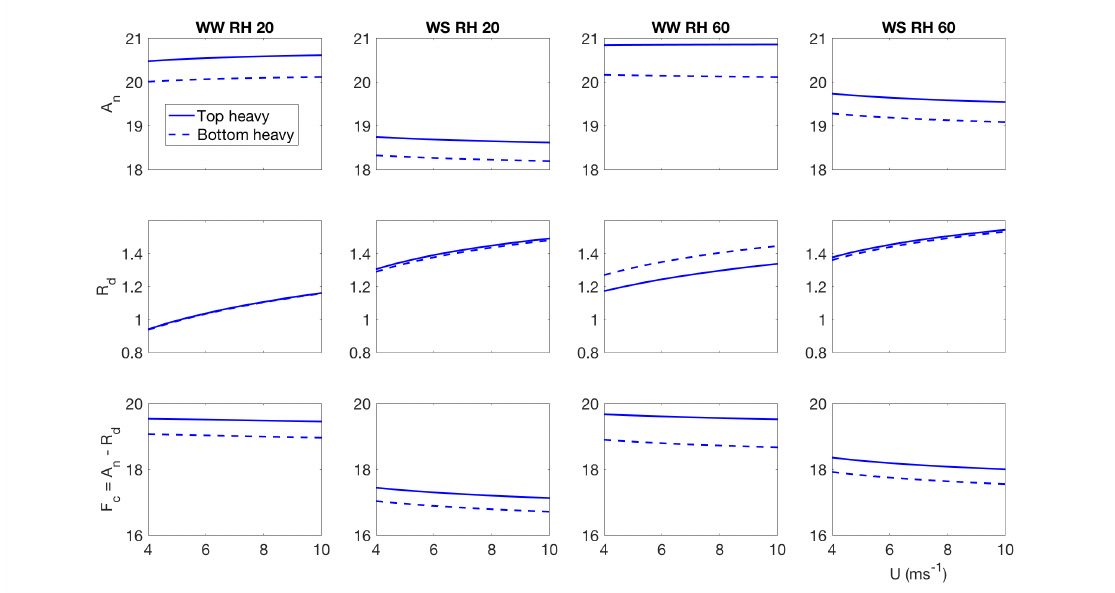
Figure 12. Canopy level outputs of carbon assimilation A n (top row), respiration R d (middle row) and net carbon dioxide flux F c (bottom row) for the low light condition. Solid line indicates top heavy and dashed line indicates bottom heavy scenario. The first column indicates well watered, high evaporative demand (WW RH20); second column indicates water stressed high demand (WS RH20), third column indicates well watered, low demand (WW RH60) and fourth column indicates water stressed low demand (WS RH60) conditions.